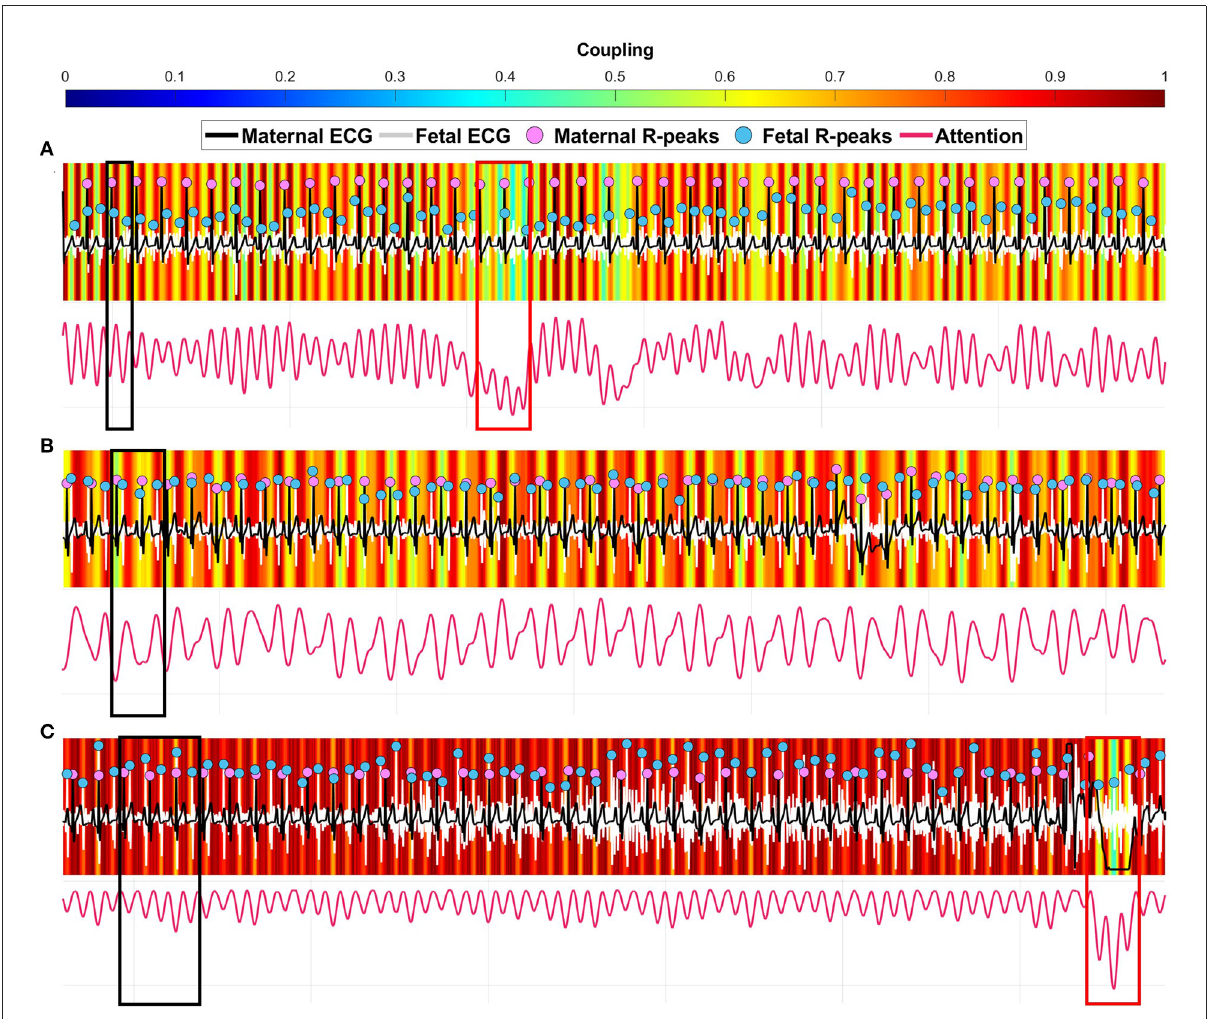
FIGURE4 Three examples of coupling heatmaps extracted from the deep learning model using the gradient-weighted class activation mapping (Grad-CAM) technique overlapped with maternal-fetal electrocardiography (ECG) signals. (A) correctly predicted [1:2] coupling 30 s segment. (B) correctly predicted [2:3] coupling 30 s segment. (C) correctly predicted [3:5] coupling 30 s segment. The black boxes show a strong coupling region for each scenario. The red boxes show a weak coupling region.